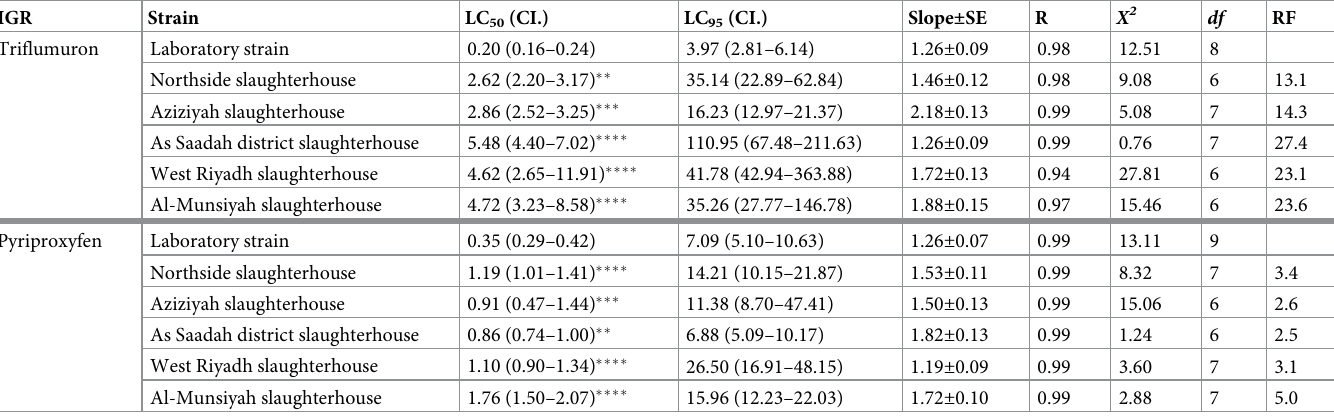
Table 1. Triflumuron and pyriproxyfen LC 50 values and resistance factors for M . domestica L. strains. IGR